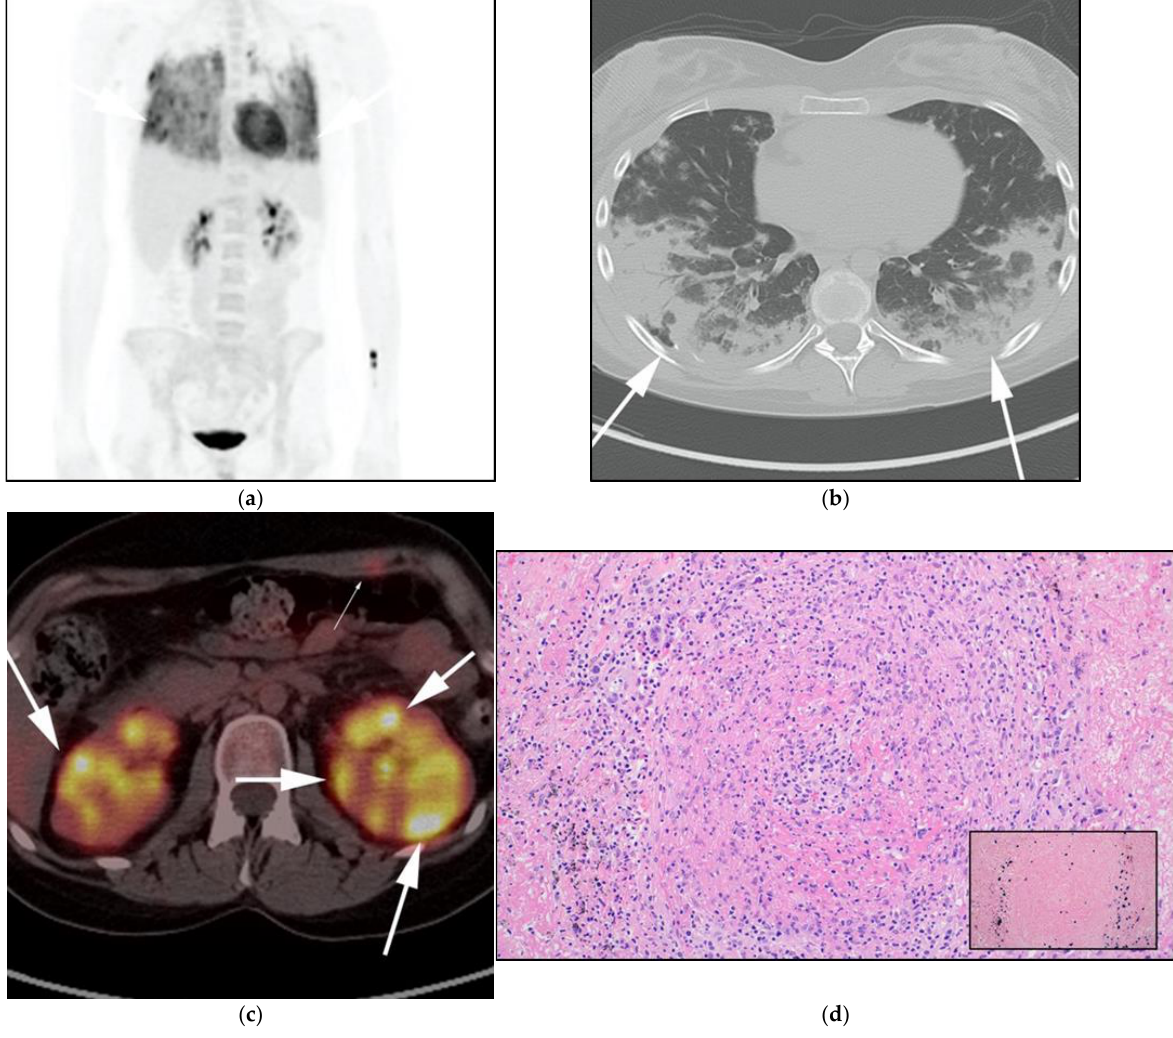
Figure 9. A 20-year-old-female with known diagnosis of lymphomatoid granulomatosis (LG) with history of rheumatoid arthritis. FDG PET/CT was ordered for staging. ( a ) Maximal intensity projection (MIP) FDG PET/CT image shows patchy hypermetabolic opacities involving the lower and mid lung zones (white arrows). ( b ) Axial CT image of the chest shows corresponding confluent consolidative patchy consolidation containing air bronchograms as well as numerous consolidative nodules (white arrows) with no mediastinal nodal involvement, a feature that might be helpful to differentiate LG from other disorders. ( c ) Interim Axial FDG/ PET/CT was obtained later and shows more numerus hypermetabolic renal masses (white arrows) and left anterior abdominal wall musculature masses (thin white arrow). ( d ) Microscopic picture of lymphomatoid granulomatosis showing angio-centric lesion with an infiltrate that is composed of a mixture of reactive appearing lymphocytes, plasma cells, and large transformed neoplastic cells. Note the inset shows the large, atypical cells are positive for in situ hybridization for EBV (dark blue stain at the periphery of the lesion). (Original magnification 400 × , H&E stain; inset is EBER in situ hybridization